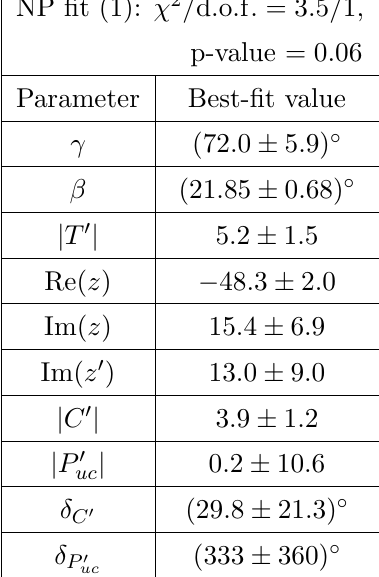
Table 8 . (cid:31) 2 = d : o : f : and best-(cid:12)t values of unknown parameters [ z and z 0 are de(cid:12)ned in eq. (4.4)] min for the Z 0 model where NP is present in B ! (cid:25)K , but only P 0 data, measurements of (cid:12) and (cid:13)